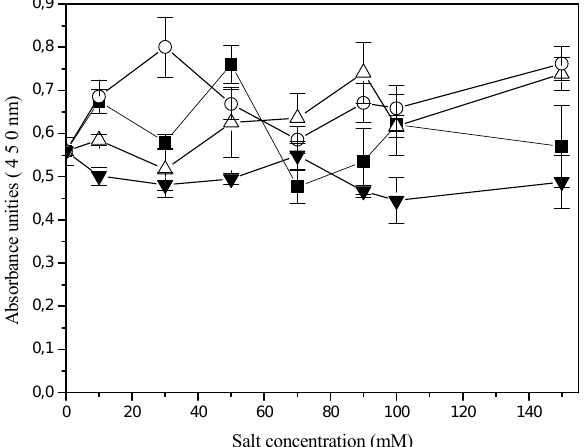
Figure 3. Immunological identity of the soluble Dtxd fractions. The kosmotropics (o) and NaCl ( ∆ ) or the chaotropics KSNC ( (cid:132) ) and MgCl NaHPO 4 Dtxd solution in water and emulsified in the presence of CH soluble fractions were analyzed by ELISA. Control: untreated protein with an absorbance of 0.52 absorbance